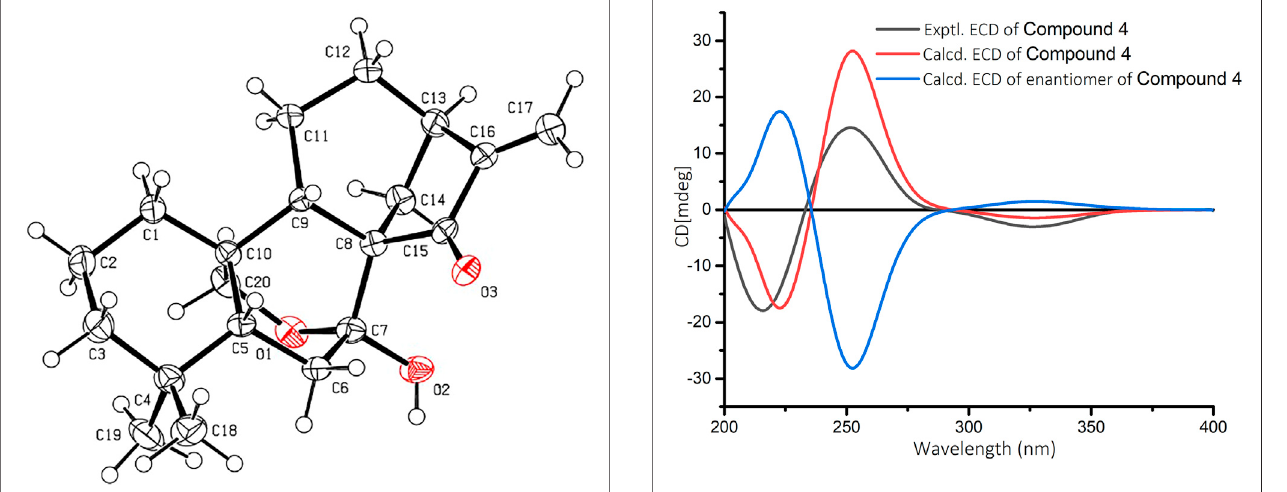
FIGURE 6 | X-ray ORTEP drawing of 3 (with a thermal ellipsoid probability of 30%).